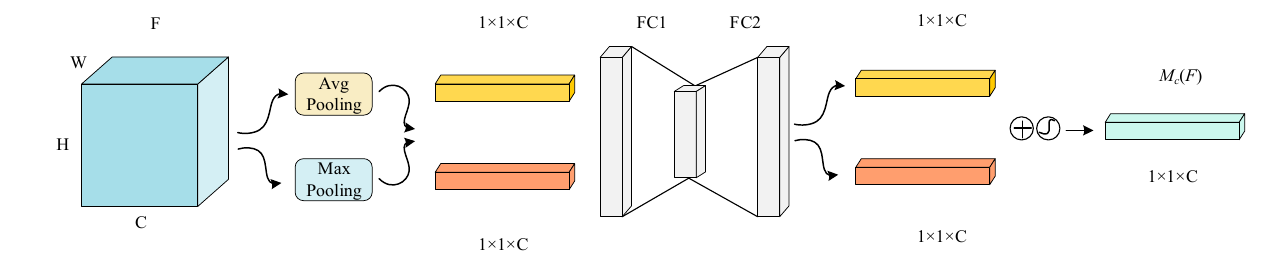
Figure 3. CAM module structure.